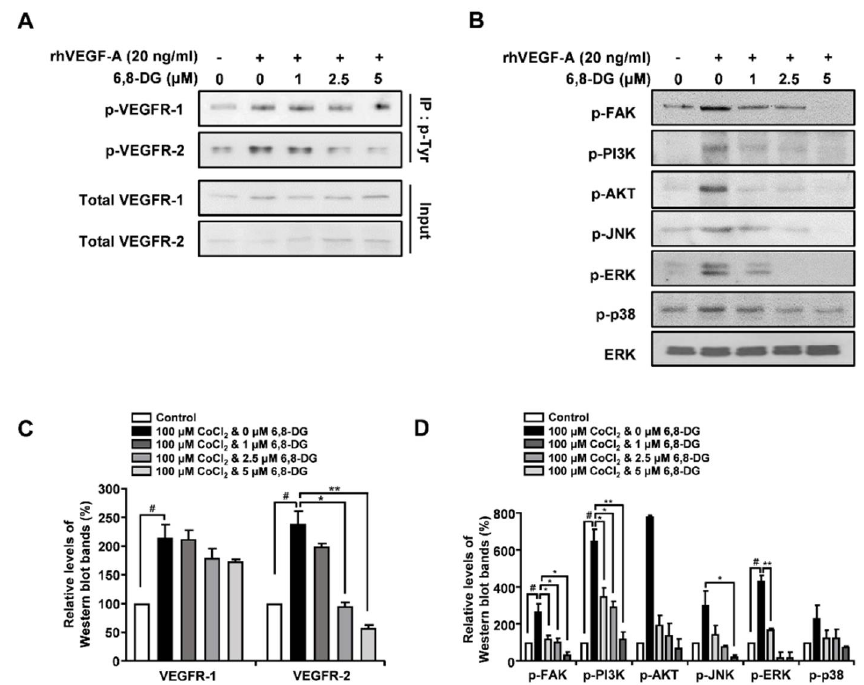
Figure 5. Effects of 6,8-DG on activation of VEGFR-1, VEGFR-2 and lymphangiogenesis-related downstream signaling factors in rhVEGF-A-treated HLMECs. ( A , C ) Cell lysates were immunoprecipitated with anti-phospho-Tyr (anti-p-Tyr). The levels of phosphorylated VEGFR-1 and -2 in immunoprecipitates were detected using Western blot analysis with anti-VEGFR-1 and anti-VEGFR-2 antibodies. ( B , D ) HLMECs were serum starved for 6 h, then were treated with different concentrations of 6,8-DG (0,1, 2.5, 5 μM) in the presence of rhVEGF-A (20 ng/mL) for 30 min. The phosphorylation levels of FAK, PI3K, AKT, JNK, ERK1/2, and p38 were determined using Western blot analysis with anti-p-FAK, anti-p-PI3K, anti-p-AKT, anti-p-JNK, anti-p-ERK1/2, and anti-p-p38 antibodies. Data are presented as a mean ± S.D. of three independent experiments ( # p < 0.01, * p < 0.05, ** p < 0.01).